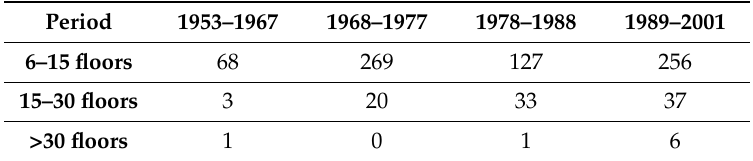
Table 2. Number of tower buildings in Greater Tel-Aviv area; according to number of floors; 6–15, 15–30, and >30 floors, following Margalit (2001) [29]. The tower buildings in the Table were built in the Greater Tel-Aviv area since 1953, during the pertinent